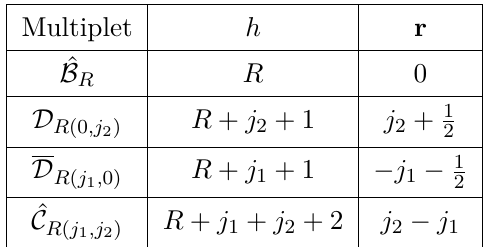
symmetry and the Lorentz R , and j take non-negative 1 2